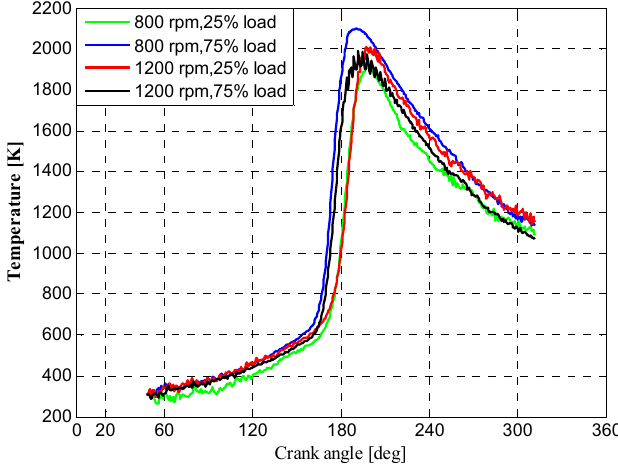
Figure 12. In-cylinder temperature at four working conditions.